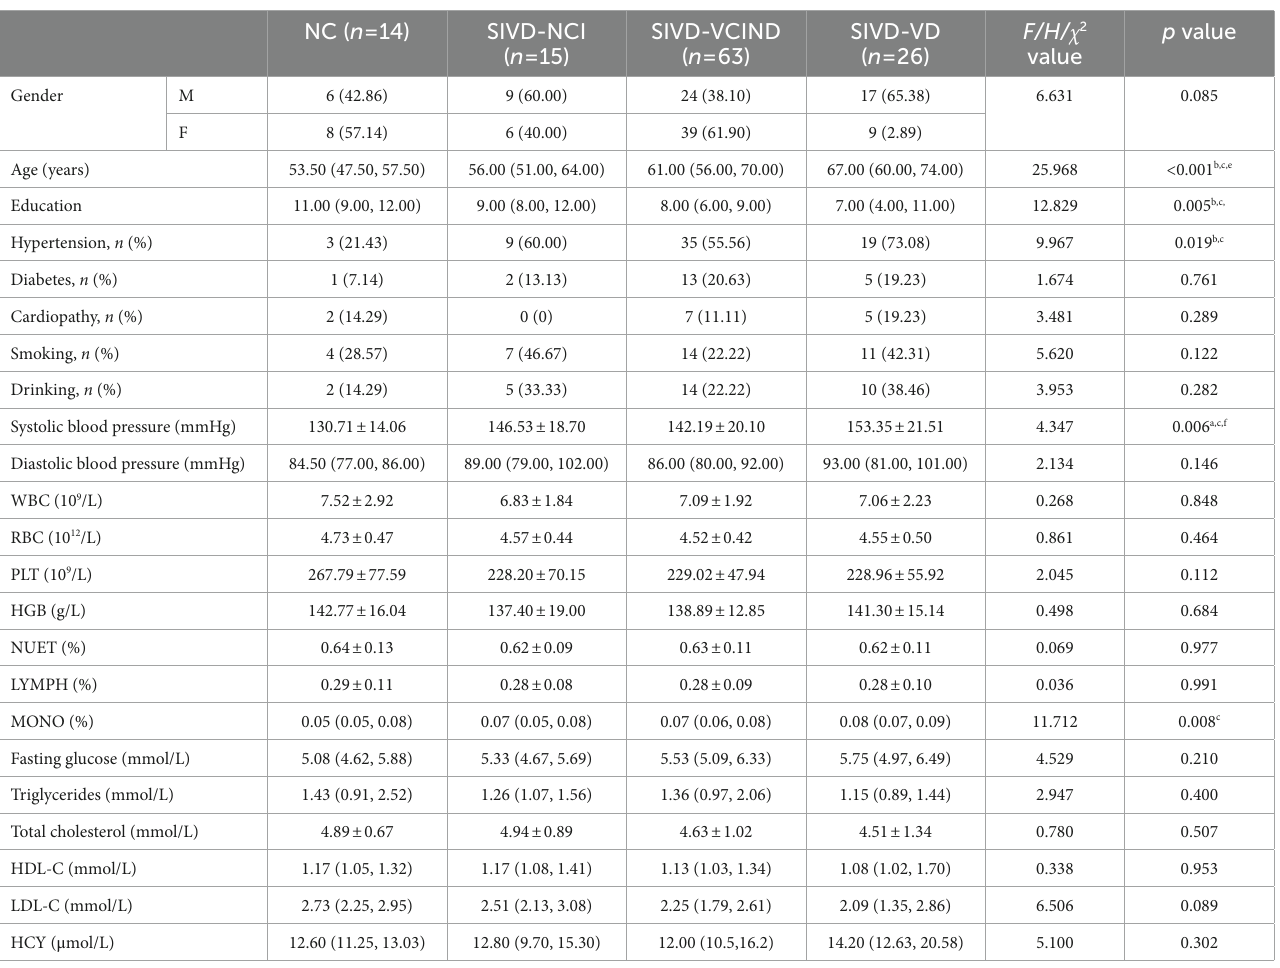
TABLE 1 Demographic and clinical characteristics of